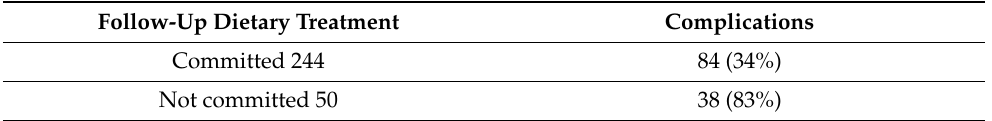
Table 2. Effect of dietary management in prevention of PKU